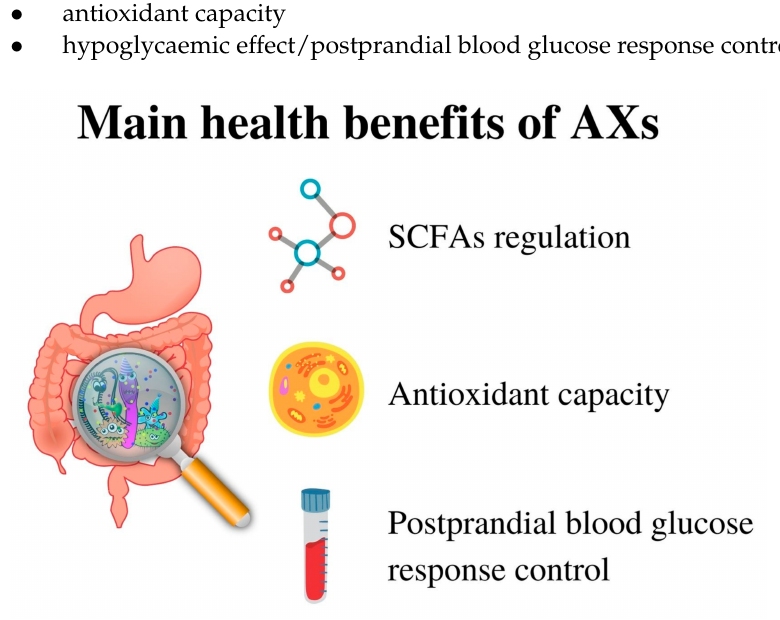
Figure 2. Main health benefits of arabinoxylans